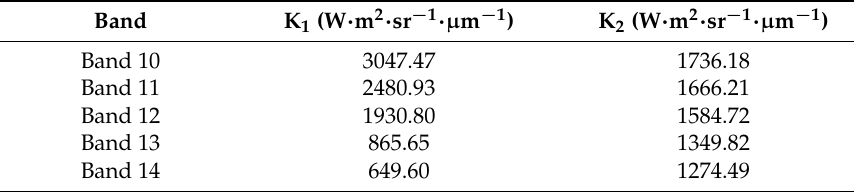
Table 5. K 1 and K 2 coefficients of the TIR bands of the ASTER instrument